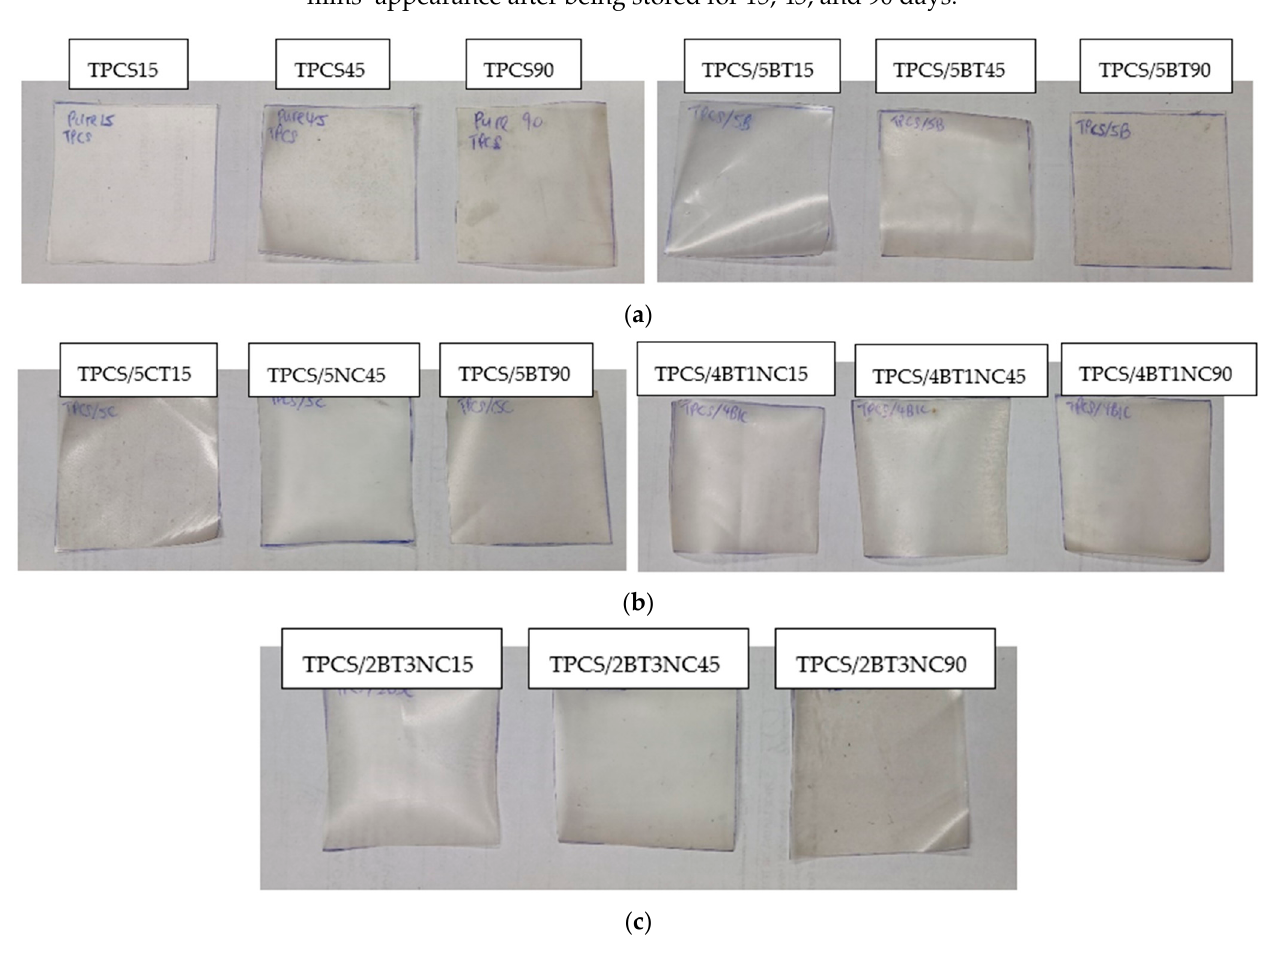
Figure 1. The physical appearance of virgin TPCS, TPCS-C, and TPCS-HC films aged for ( a ) 15, ( b ) 45, and ( c ) 90 days.